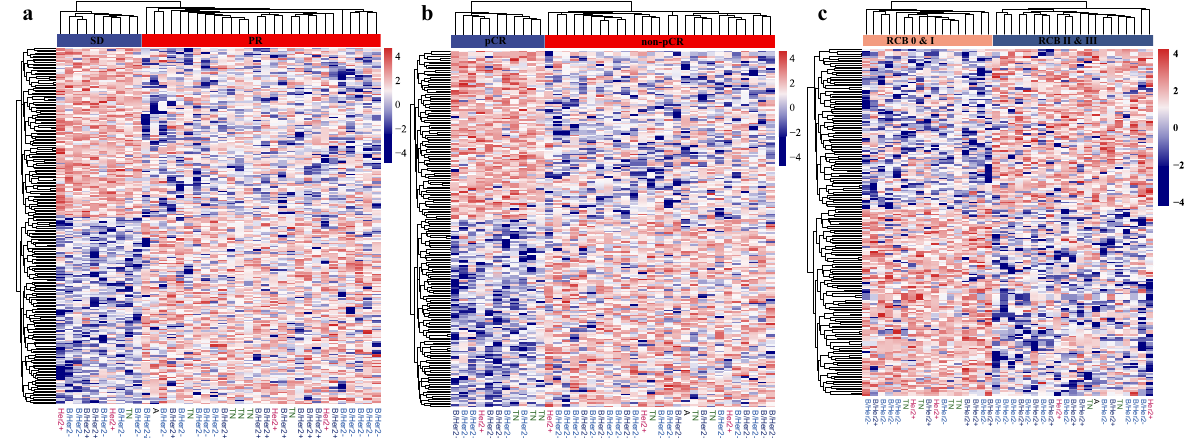
Fig. 6 Different TSSs in pretreatment samples. Different TSSs between responders (PR) and nonresponders (SD) ( a ), between patients with pCR and npCR ( b ) and between patients with low RCB (RCB 0 & I) and high RCB (RCB II & III) by hierarchical clustering analyses. Red and blue represent relatively high and low coverage,